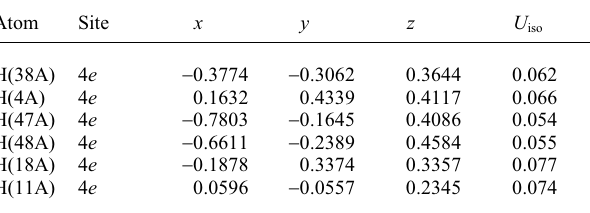
Table 2. Atomic coordinates and displacement parameters (in Å 2 )